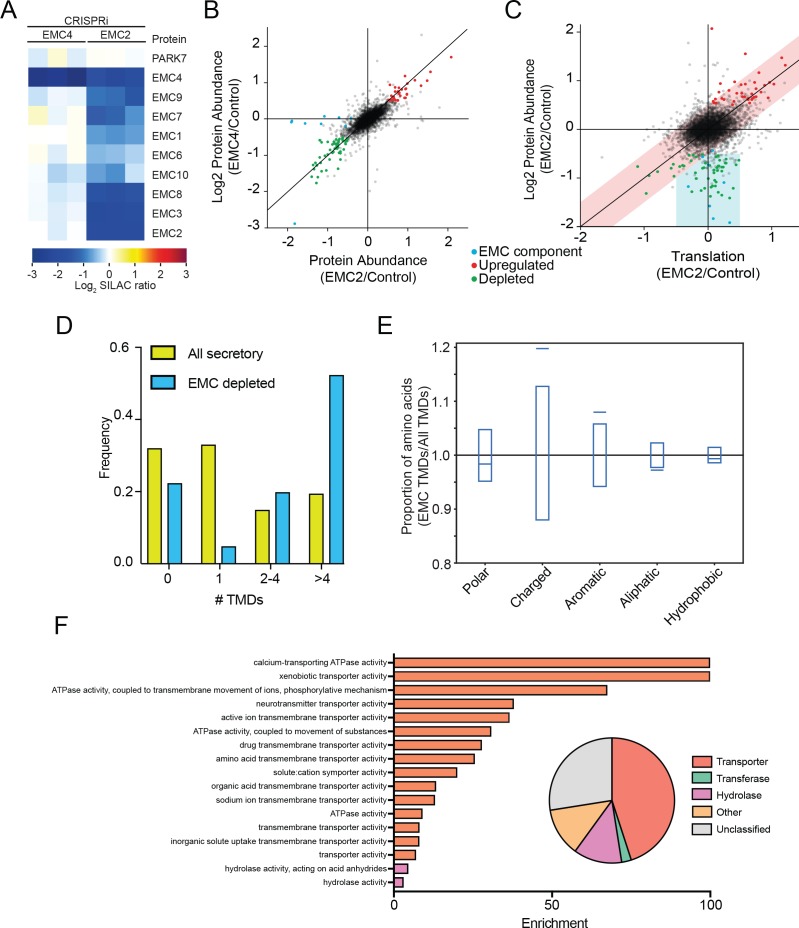
The mammalian EMC stabilizes multipass transmembrane proteins.(A) SILAC quantification of EMC components, comparing their expression level in cells with guide RNAs targeting EMC2 or EMC4 with those expressing non-targeting GAL4 guide RNA. PARK7 is shown as a control (Wiśniewski and Mann, 2016). (B) Full proteome comparison scatter plot of protein abundance change in cells expressing EMC2 guide RNA against abundance change in cells expressing EMC4 guide. Expression is relative to non-targeting GAL4 guide RNA. Proteins colored red are significantly upregulated in both EMC2 and EMC4 cells. Proteins colored green are significantly downregulated in both EMC2 and EMC4 cells (Log2 >0.5). EMC components are colored blue. (C) Comparison of translation change by ribosome profiling with proteome change. (D) Histogram showing the proportion of proteins containing the given number of TMDs for all proteins that enter the secretory pathway (as defined in Uniprot) and EMC clients. (E) Fraction of amino acids with the given properties in TMDs from EMC client proteins compared to all secretory proteins. Proportion of EMC TMD amino acids/all TMDs for each property is shown by a blue line. Blue boxes indicate 95% confidence ranges defined by 10,000 random sub-samplings of total TMDs with a pool size equal to EMC TMDs (N = 37). (F) Top non-redundant over-represented GOMF terms calculated from PANTHER (FDR < 0.05; redundant terms removed by REViGO). Inset: Protein classifications pie chart for EMC client proteins (N = 37).